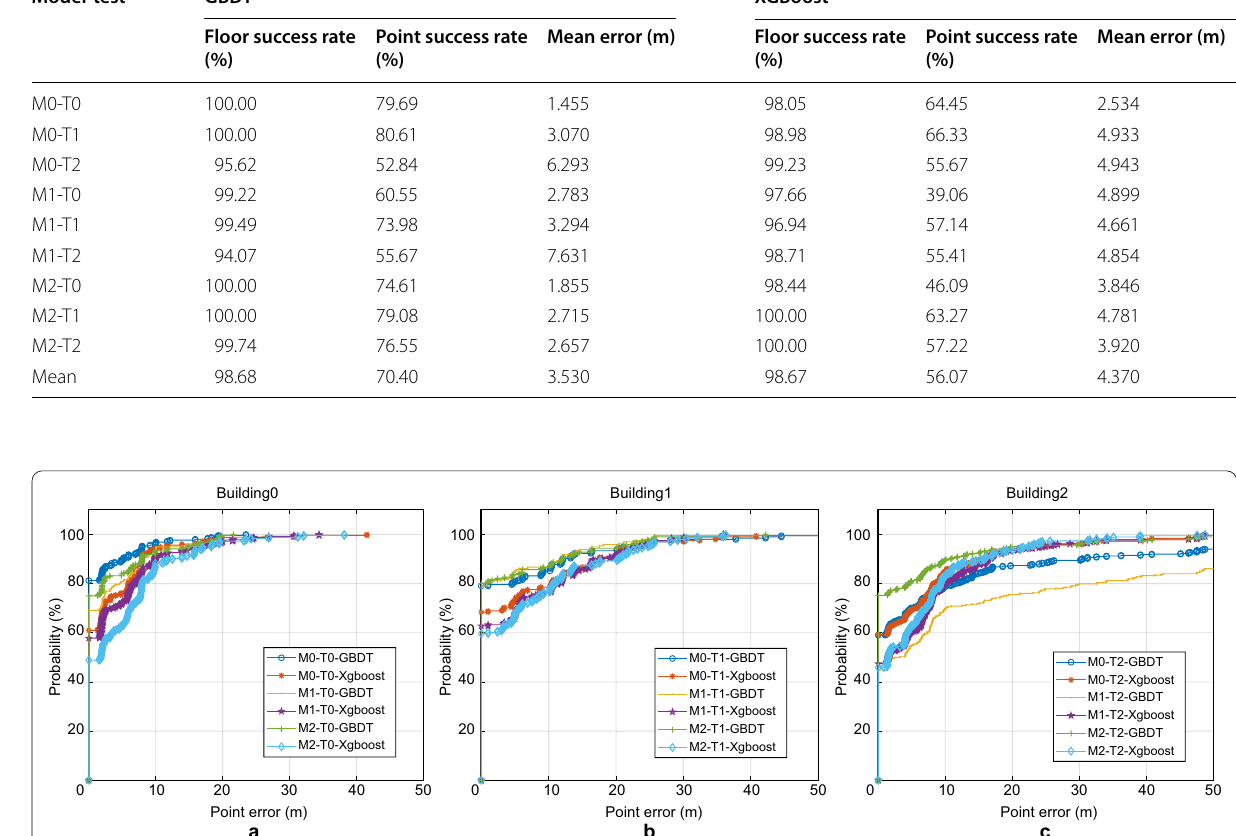
Table 10 The results of different testing samples using XGBoost and GBDT after deleting the low-score Features Model-test